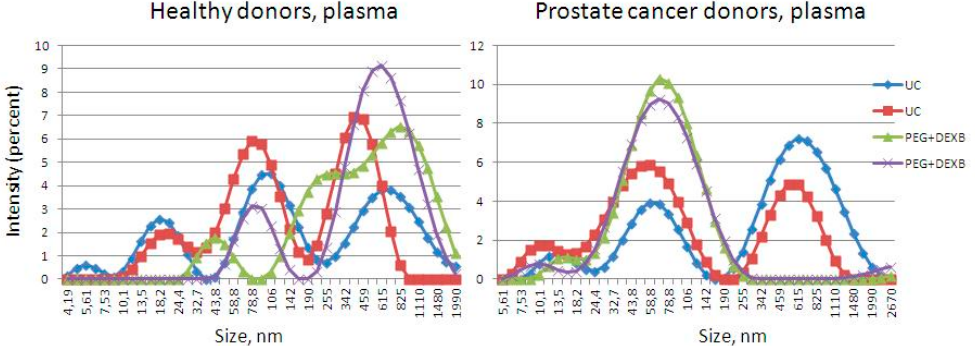
Figure 4. The size distribution of plasma extracellular vesicles isolated by precipitation (PEG+DEXB) and ultracentrifugation (UC), visualized by a Zetasizer Nano